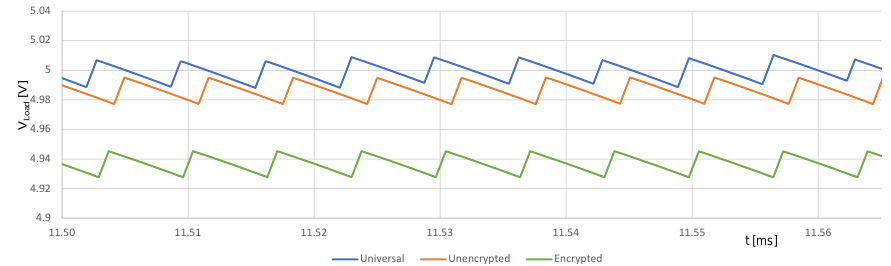
Figure 30. V Load time graph curves using LM2594 regulator.